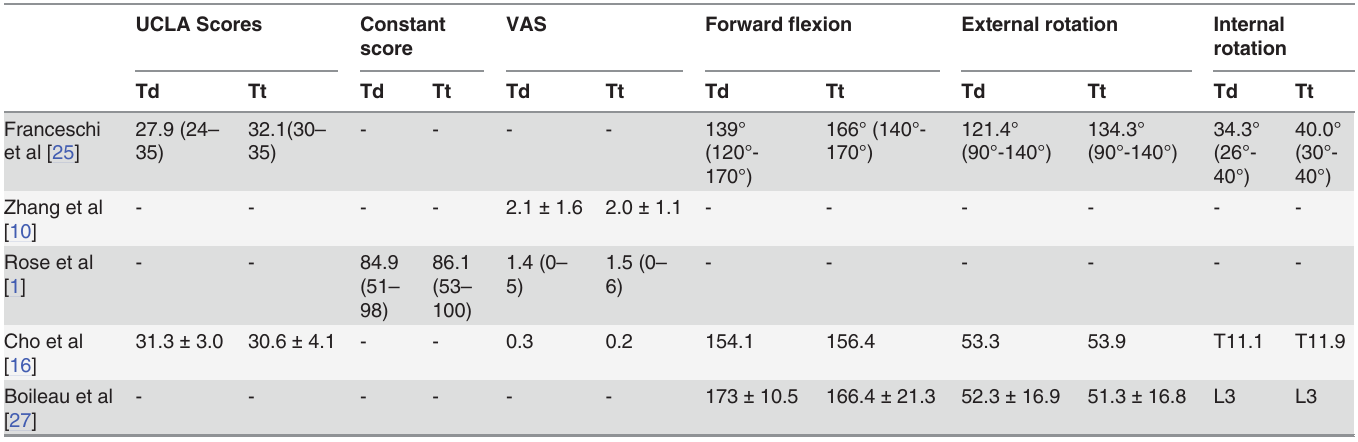
Table 5. Physical examination rating scales (meta-analysis not performed). UCLA